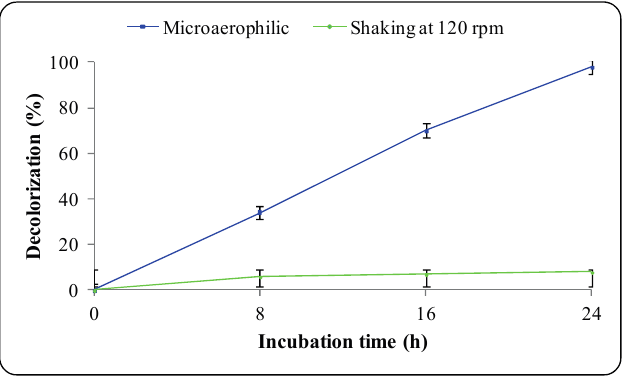
Figure 4. Effect of microaerophilic and aerobic (shaking at 120 rpm) conditions on decolorization of dye Trypan Blue (50 mg·L − 1 ) by microbial consortium at 30 ± 0.2 °C, pH